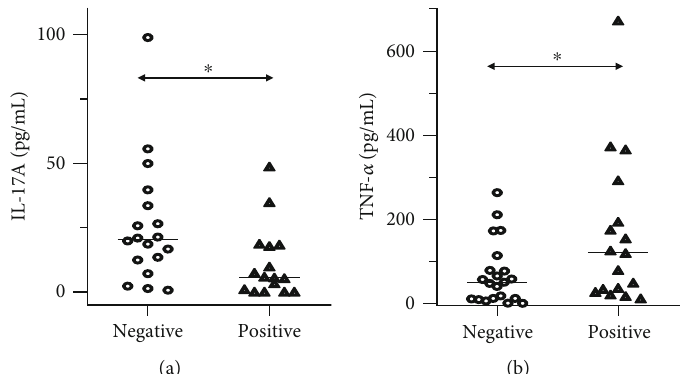
Figure 3: Di ff erences in concentrations of IL-17A and TNF- α between patients with head and neck cancers depending on results of oral swab bacterial culture. (a) There was a signi fi cant di ff erence in salivary concentration of IL-17A ( p < 0 : 05 ) between patients with negative and positive aerobic bacterial cultures. (b) There was a signi fi cant di ff erence in salivary concentration of TNF- α ( p < 0 : 05 ) between patients with negative and positive aerobic bacterial cultures. ∗ p < 0 : 05 ,